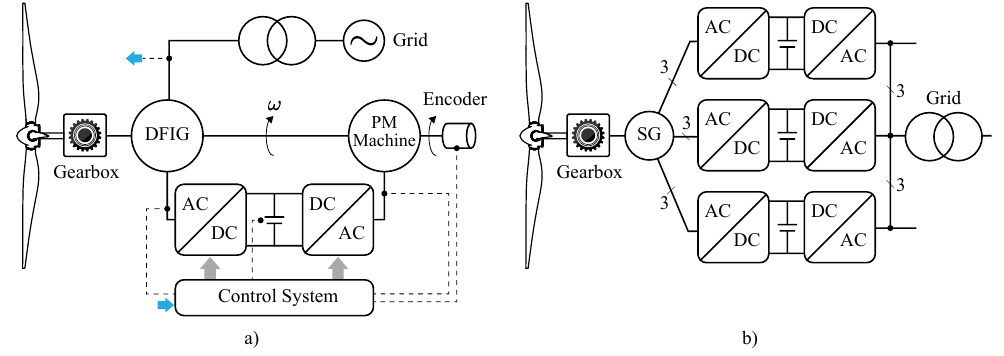
Figure 4. WECS configurations. ( a ) xDFM. ( b ) Multi-channel synchronous